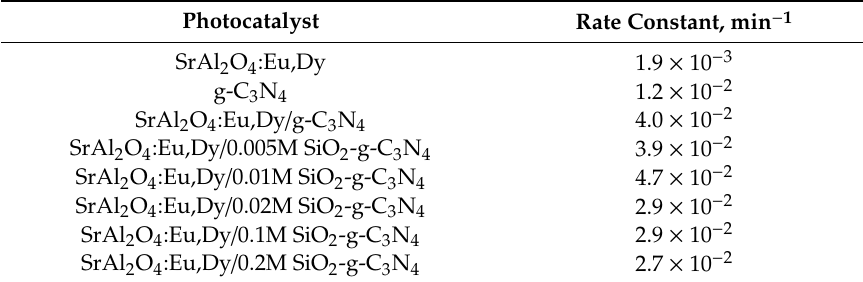
Figure 9. Photo-degradation e ffi ciency ( a ) and rate of reaction ( b ) for 50 wt.% g-C 3 N 4 supported on SrAl 2 O 4 :Eu,Dy / SiO 2 in MB solutions under visible light illuminations. Table 5. Rate constants for visible light